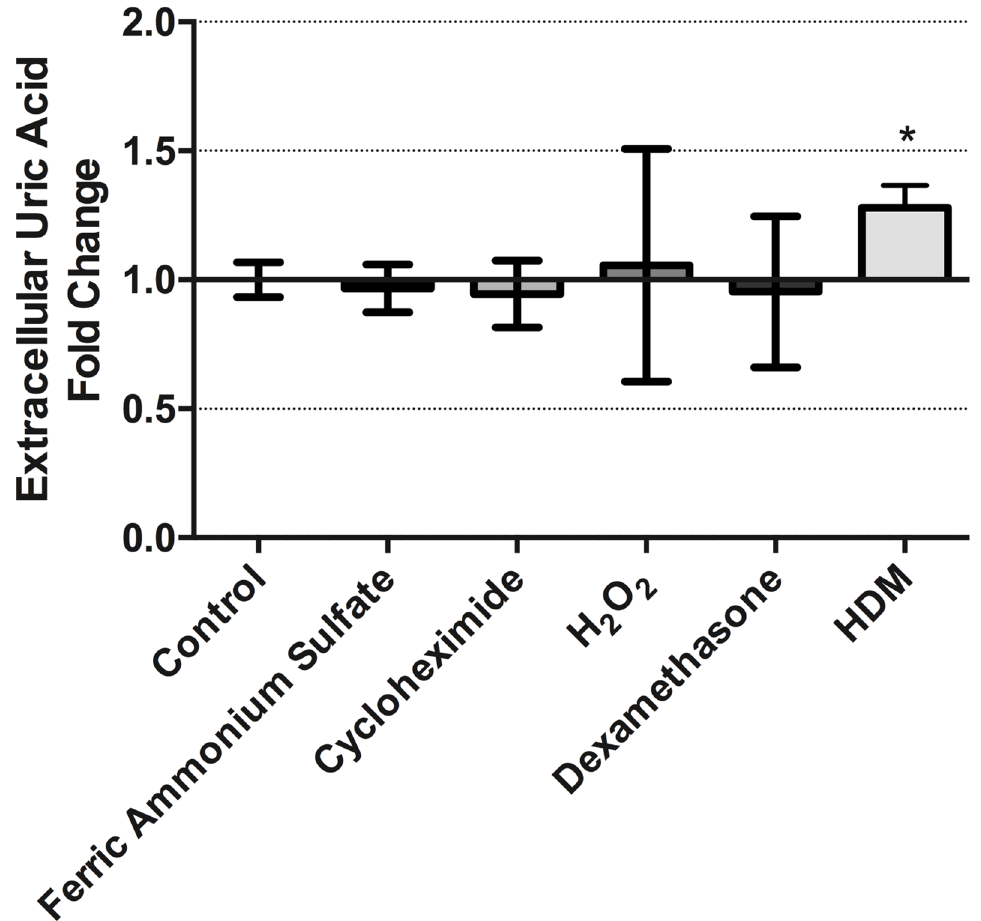
Fig 4. Extracellular uric acid levels in cultured human airway epithelial cells are not augmented by diverse chemical exposures. Treatment of HBEC-6KT humanairway epithelialcells with ferric ammonium sulfate (50 μ M), cycloheximide (0.01 μ g/ml), H 2 O 2 (100 μ M), and dexamethasone (10 μ g/ml) for 24h did not induce elevations in extracellular uric acid levels in contrast to the positive control of HDM (50 μ g/ml). Data represent mean +/- SD, n = 3. Significance is represented by * = p < 0.05relative to control.